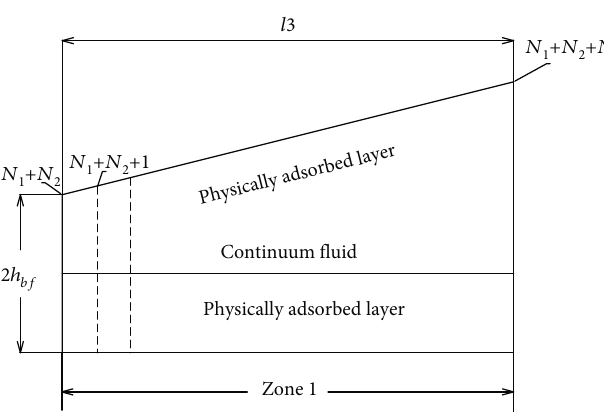
Figure 5: The discretized points in the zone 1 of the inlet zone.